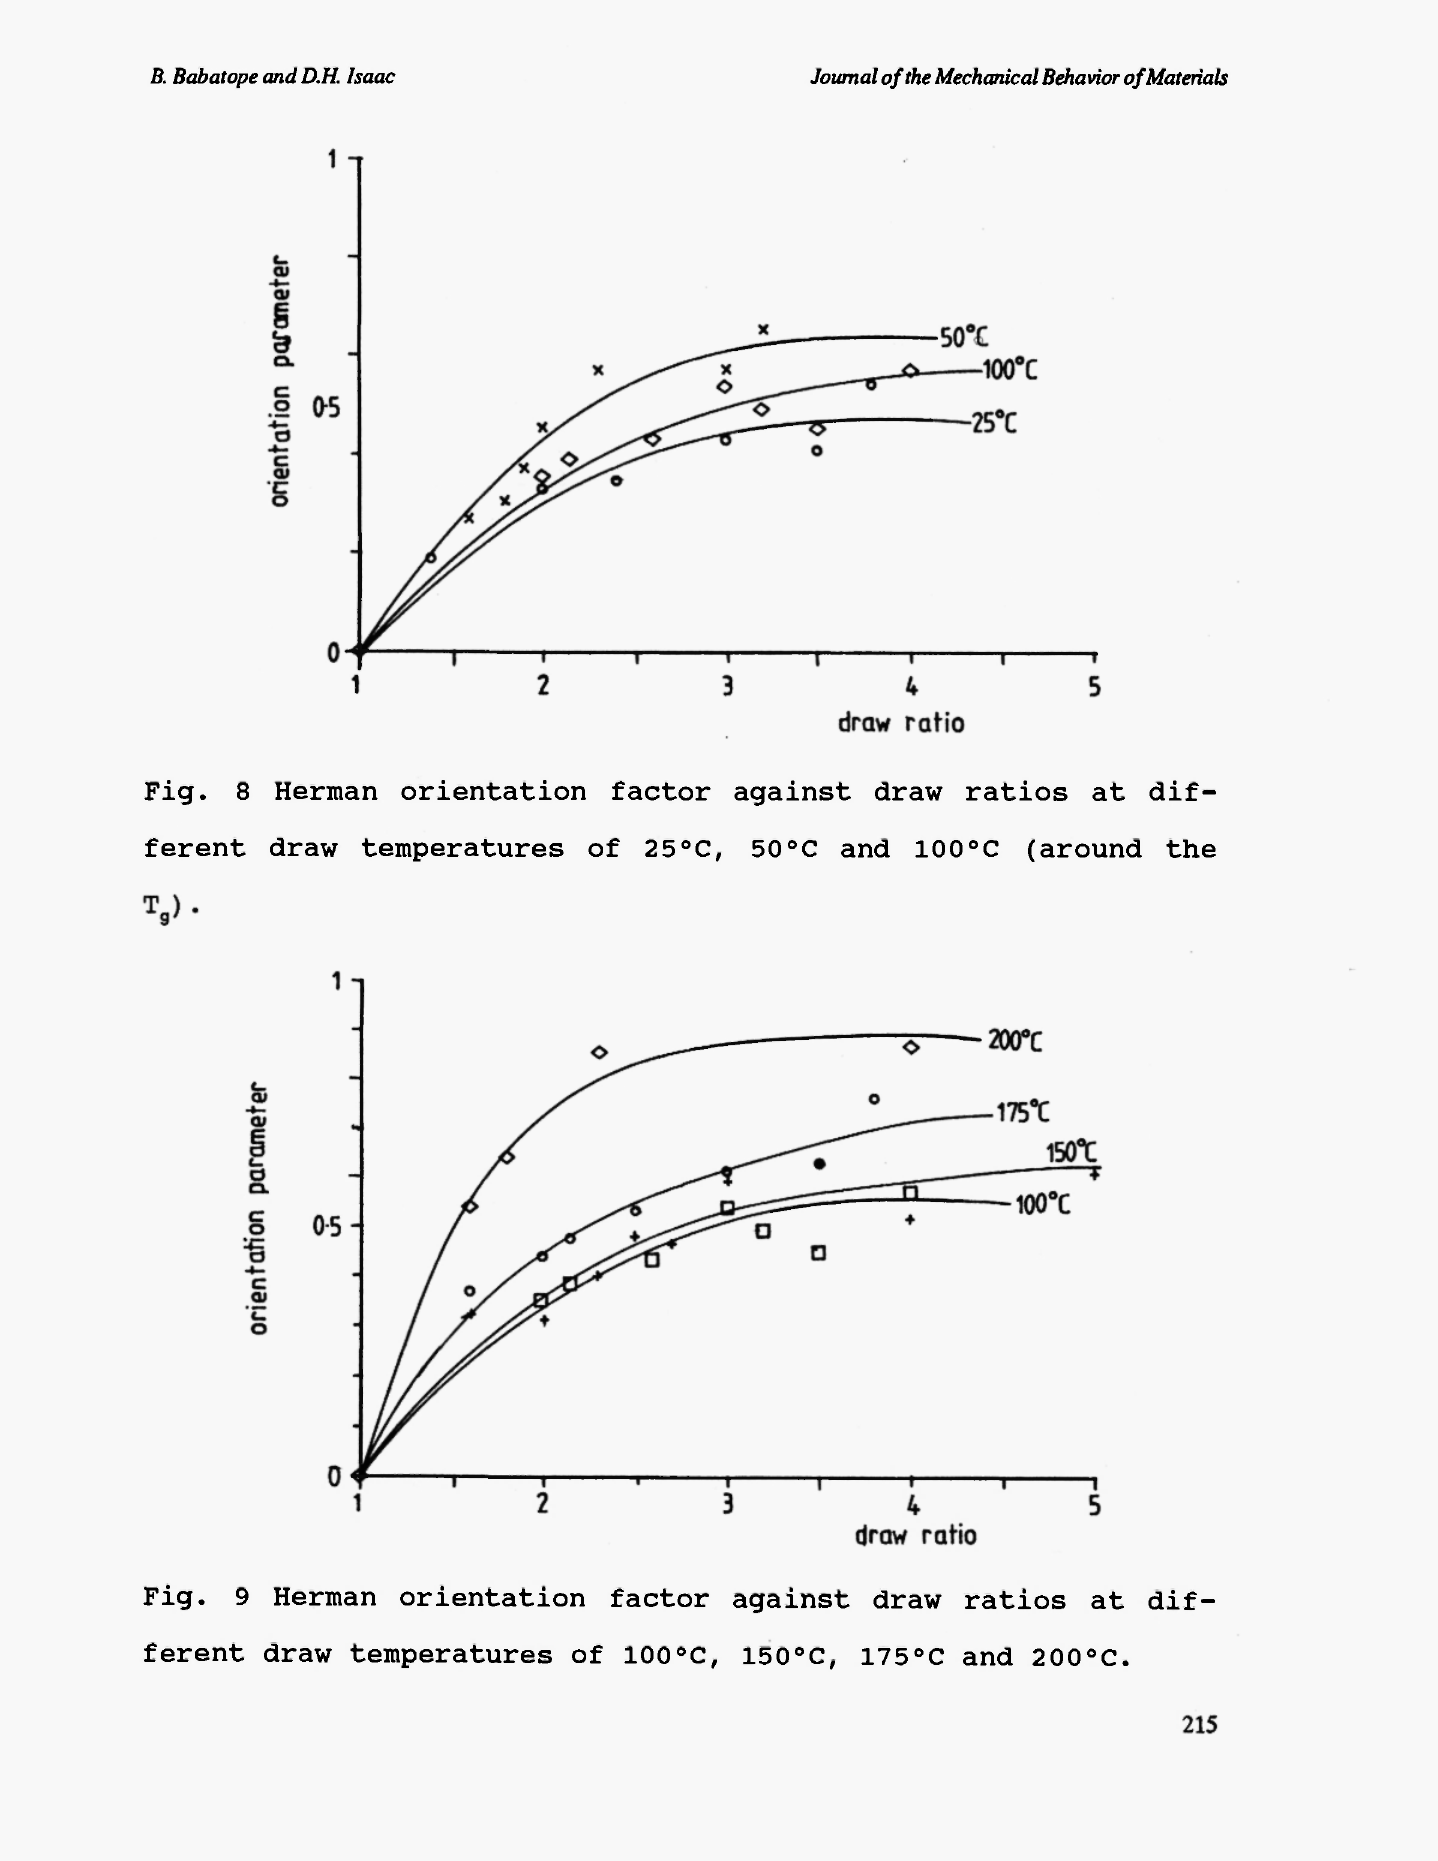
9 Herman orientation factor against draw ratios at dif- ferent draw temperatures of 100°C, 150°C, 175°C and